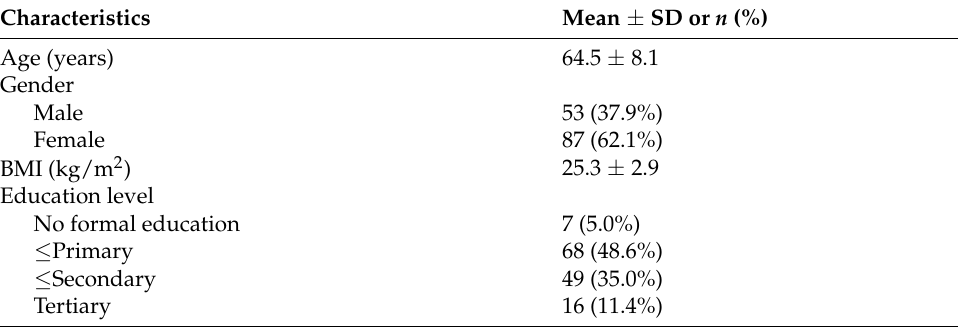
Table 2. Characteristics of the Chinese participants with CHD or CHD risk factors ( n = 140).